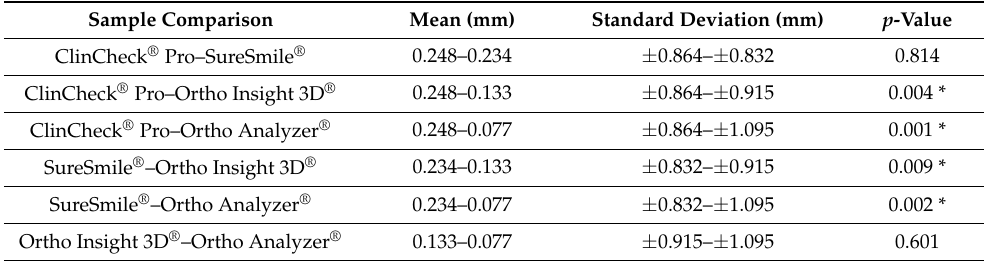
Table 3. Pairwise comparison for translation buccal/lingual.